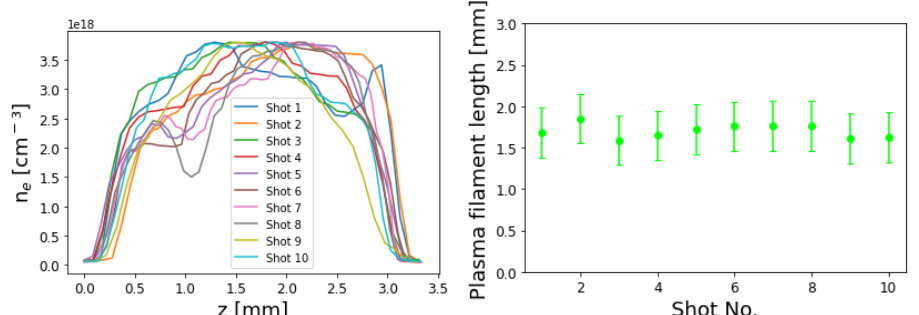
Figure 3. ( Left ): Reconstructed electron plasma density axial profiles from the Thomson scattering optical diagnostics. ( Right ): shot-to-shot fluctuation of the plasma filament length, assumed to be as long as the electron acceleration length; the uncertainty is determined by the resolution of the imaging